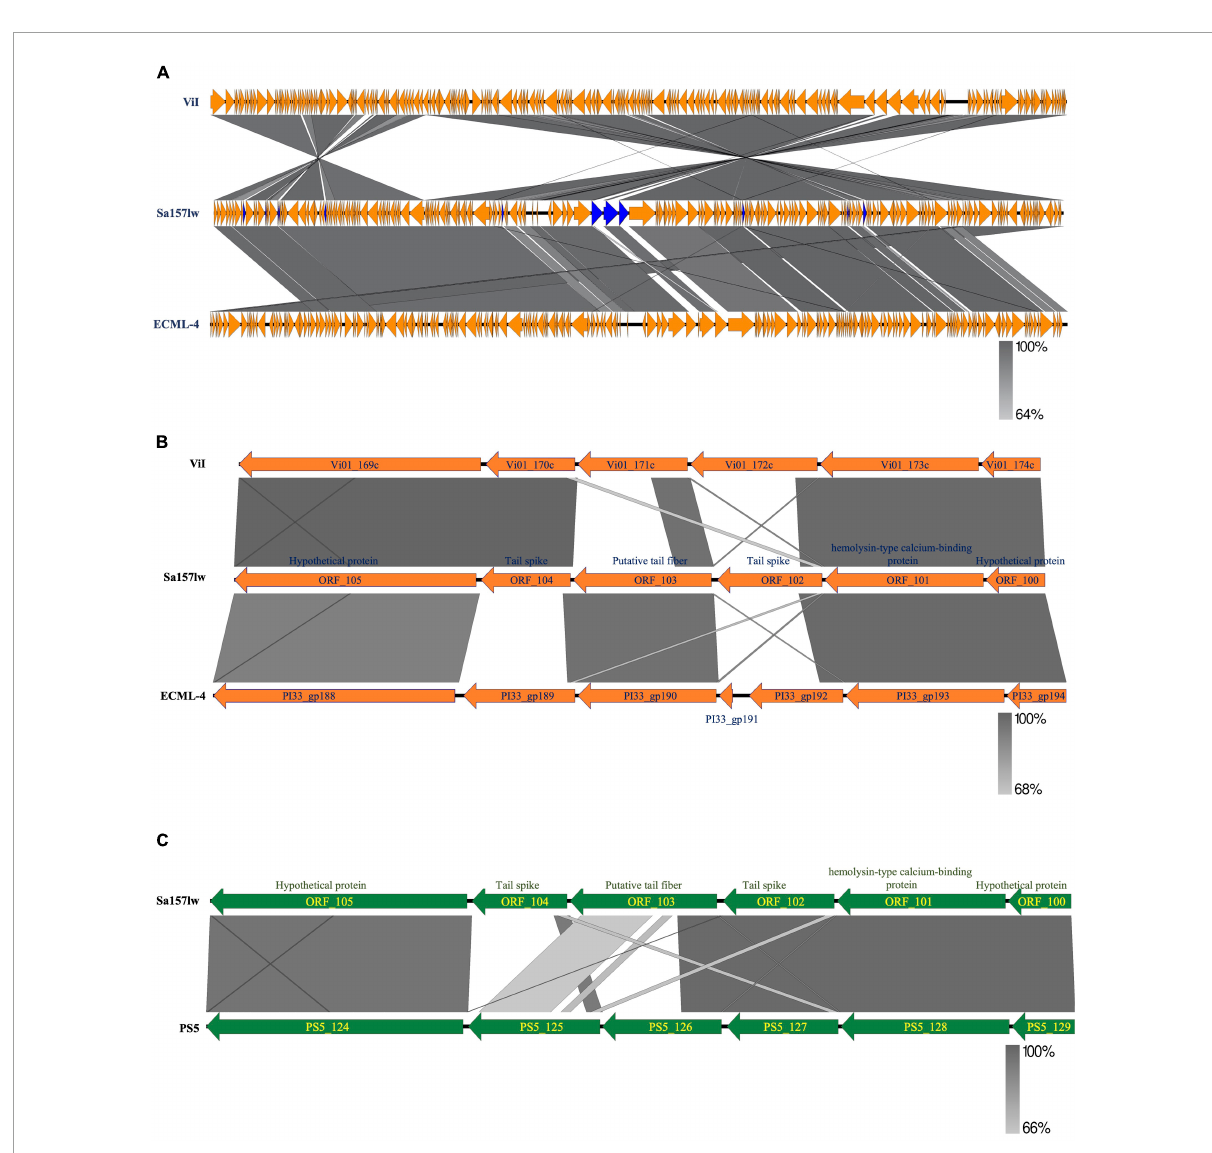
FIGURE2 Genome comparison of the whole genome of Sa157lw and its close-related Kuttervirus ViI and E. coli phage ECML-4 (A) , the sequence region of tail fiber and tail spike (B) , and the same gene cluster between phages Sa157lw and PS5 (C) using EasyFig v2.2.5. Whole genome maps are presented as orange arrows, indicating the order of annotated ORFs from left to right along the phage genomes. The sequence regions of the tail-related gene cluster are presented as orange or green arrows. Regions of sequence similarity are connected by a gray-scale shaded area. The unshared ORFs between Sa157lw and ViI or ECML-4 are in blue. The sequence direction is adjusted for comparing the regional